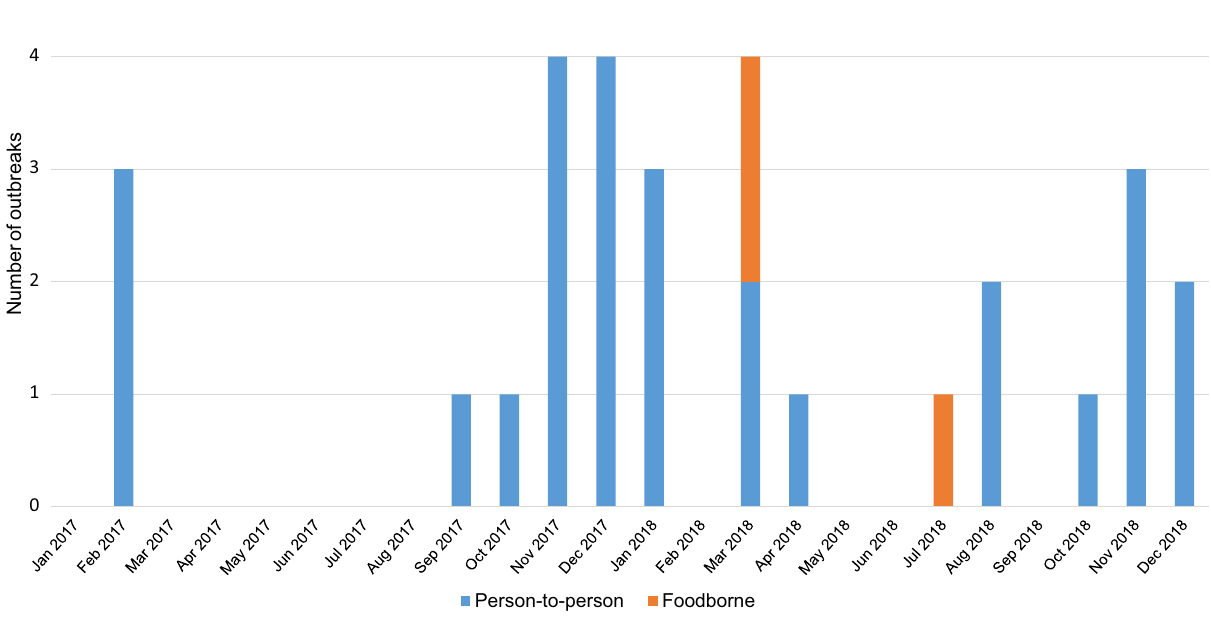
Figure 1. Number of acute gastroenteritis outbreaks due to norovirus in long-term care facilities according to the month of onset and mode of